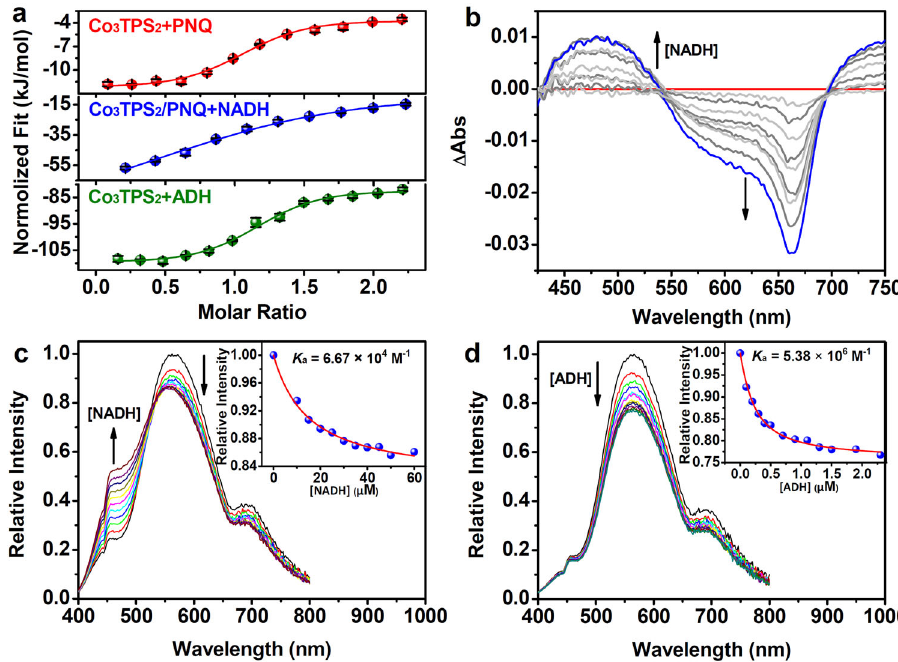
Fig. 5 Characterization of host – guest interactions between Co 3 TPS 2 and PNQ or NADH. a Isothermal titration calorimetry tests of Co 3 TPS 2 upon addition of PNQ (red) and ADH (green), and of the mixture of Co 3 TPS 2 and PNQ upon addition of NADH (blue). Error bars are the calculated standard error from the curve fi t. b UV-Vis absorption difference spectra of PNQ (0.1 mM) and Co 3 TPS 2 (0.1 mM) in EtOH/H 2 O (3:2) upon the addition of NADH. c Luminescence spectra family of PNQ (0.1 mM) and Co 3 TPS 2 (0.1 mM) in EtOH/H 2 O (3:2) upon the addition of NADH. Inset: Hill plot of the fl uorescence intensity with a non-linear fi tting at 560 nm (1:1 binding model). d Luminescence spectra family of PNQ (0.1 mM) and Co 3 TPS 2 (0.1 mM) in EtOH/H 2 O (3:2) upon the addition of ADH. Inset: Hill plot of the fl uorescence intensity with a non-linear fi tting at 560 nm (1:1 binding